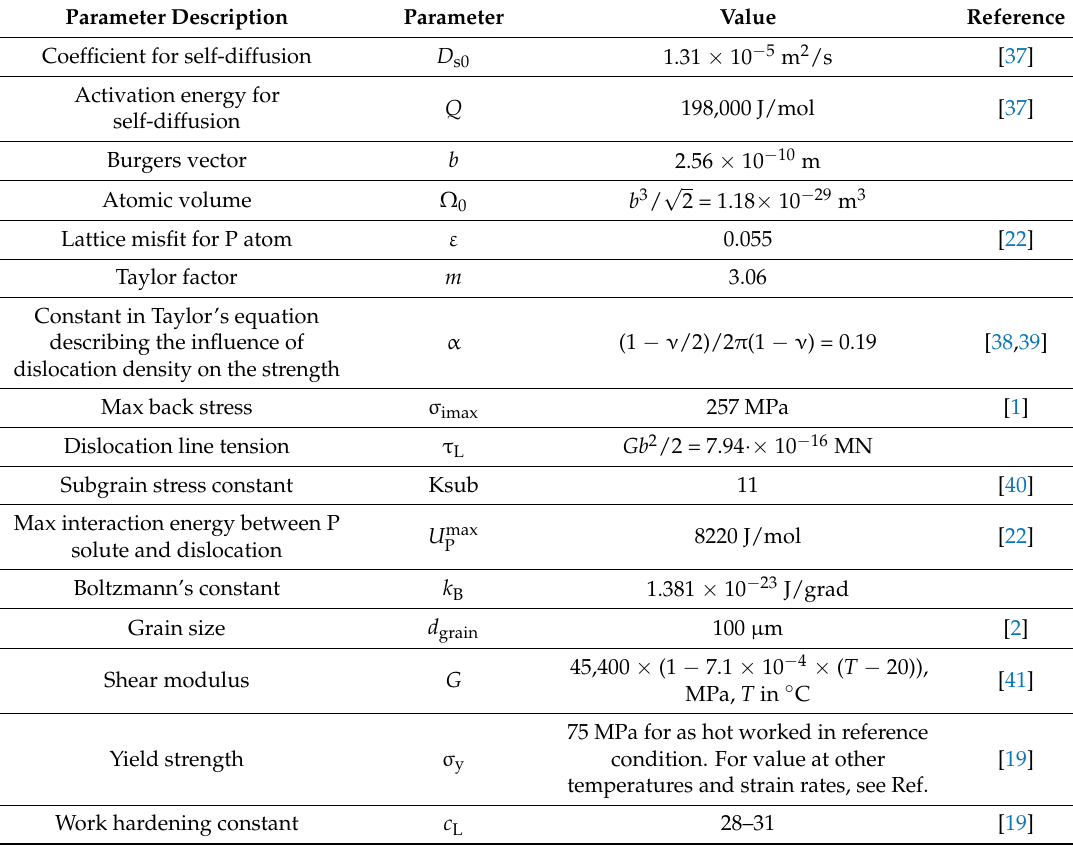
Table A1. Values and interpretation of